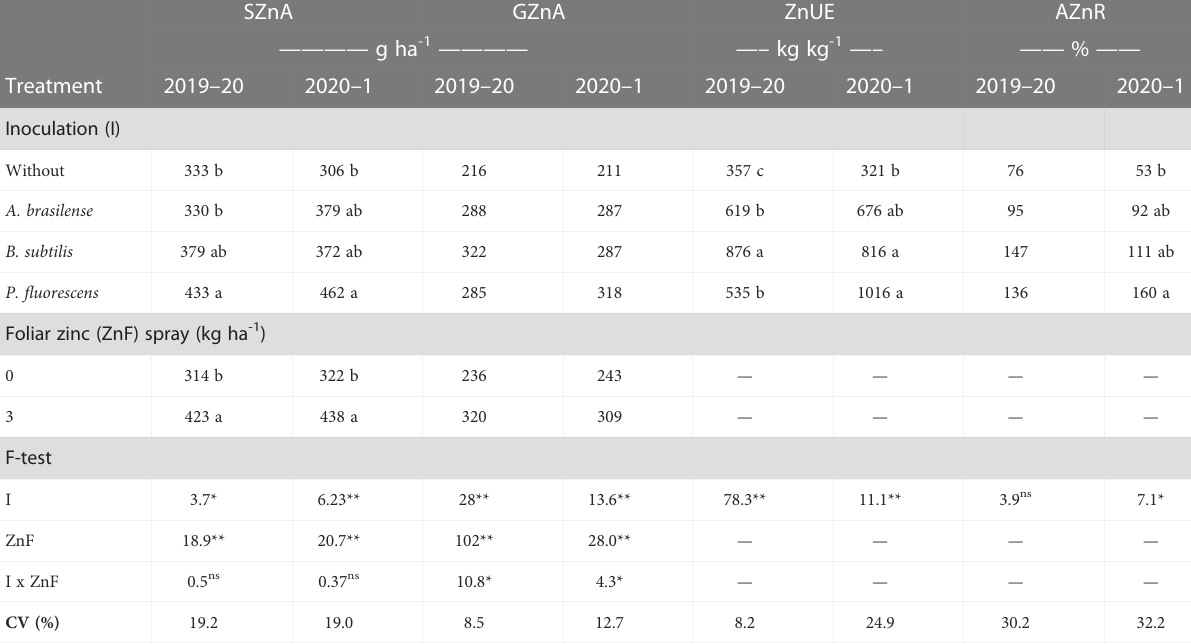
TABLE 4 Shoot zinc accumulation (SZnA) and grain zinc accumulation (GZnA), zinc use ef fi ciency (ZnUE), and applied zinc recovery (AZnR) as a function of plant growth-promoting bacteria inoculation, together with or without nano-zinc oxide spray in the 2019 – 20 and 2020 – 1 cropping seasons.